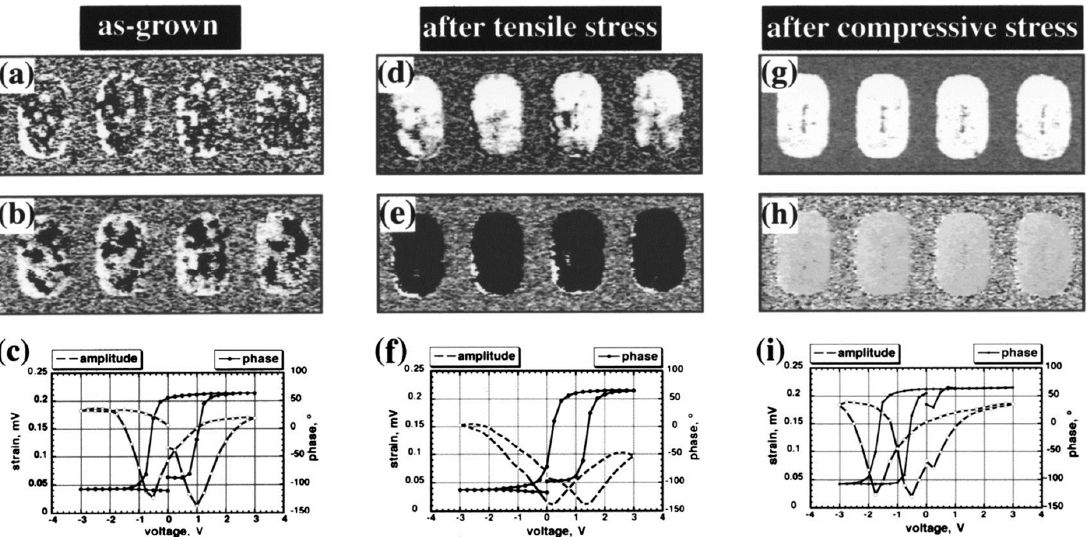
Figure 19. PFM images illustrating the impact of stress (generating the flexoelectric effect) on the polarization and switching behavior of (111)-oriented PZT capacitors. ( a – c ) Before applying stress: PFM amplitude ( a ) and phase ( b ) images of as ‐ grown capacitors and a local hysteresis loop ( c ) measured near the edge of one of the capacitors. ( d – f ) After applying tensile stress: PFM amplitude ( d ) and phase ( e ) images of the same capacitors and a hysteresis loop ( f ) measured at the same site. ( g –